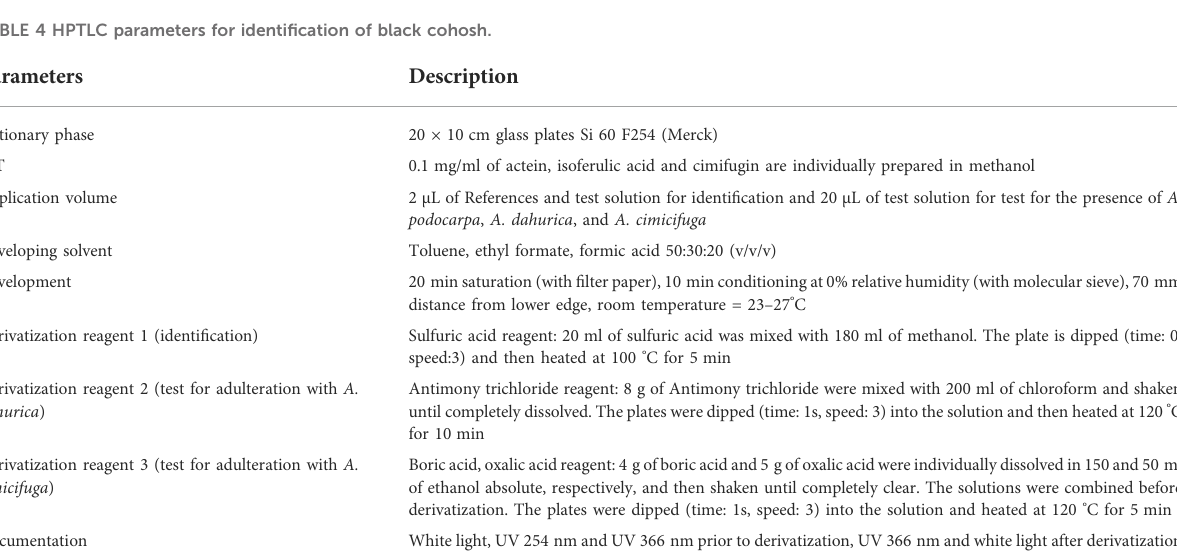
TABLE 4 HPTLC parameters for identi fi cation of black